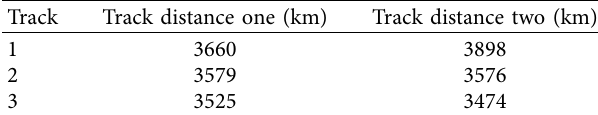
Table 3: Three trajectory distances from Madrid to Cairo.